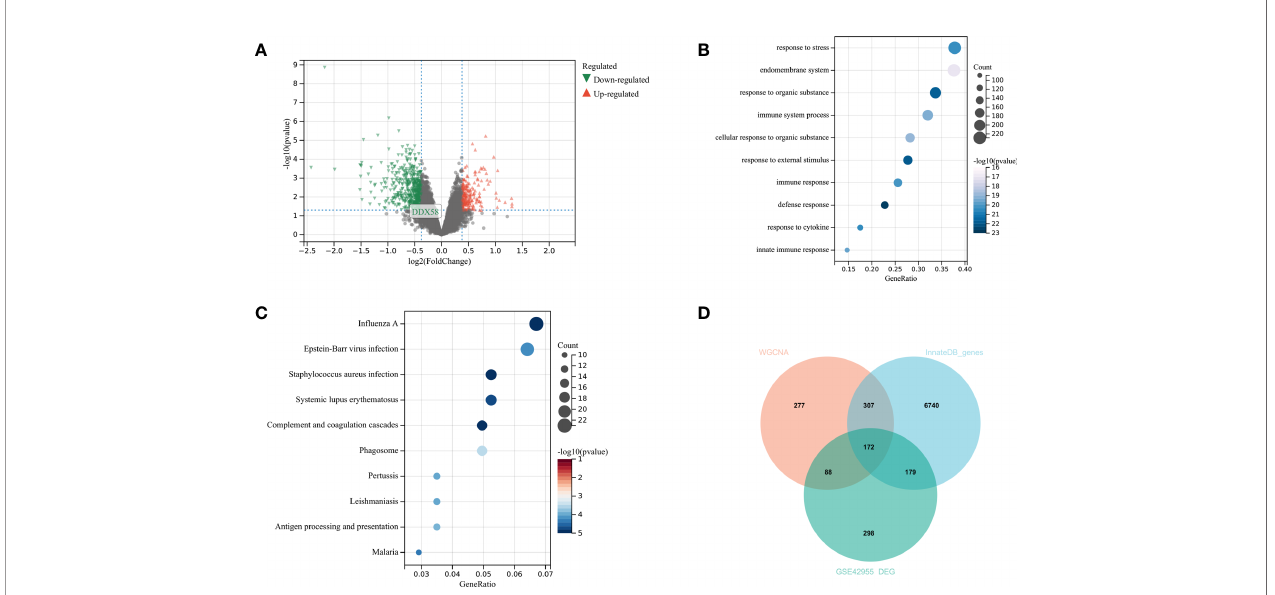
FIGURE 3 | Analysis of differences in GSE42955 (A) Volcano plot of signi fi cant DEGs between ischemic heart failure and normal control samples; (B, C) top 10 enriched GO terms and KEGG pathways of DEGs, respectively; (D) Venn diagram of DEGs, WGCNA key modules and immune gene